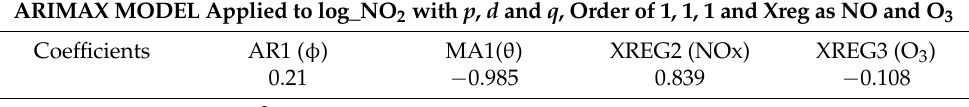
Table 7. Estimating the parameters of the ARIMAX (1,1,1) model for the NO 2 concentrations ( µ g/m 3 ) training dataset, with NO and O 3 as exogenous variables.